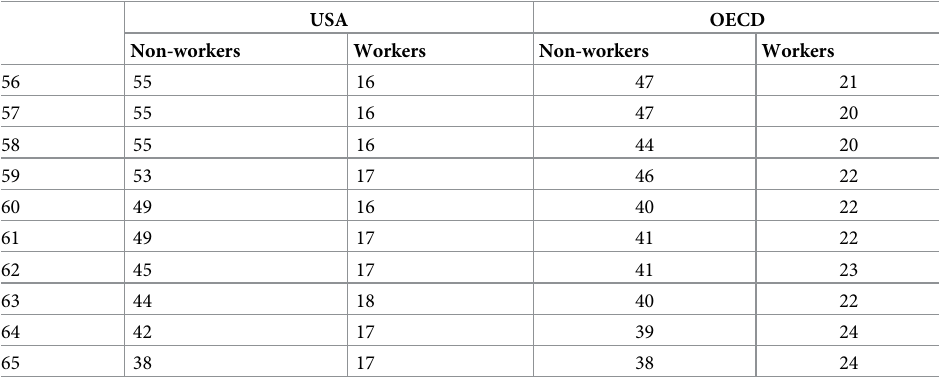
pain rates in the United States through age 60. When we change employment rates in the United States they resemble the age profile of pain elsewhere in the OECD. We are then left with the puzzle: why should pain be hump-shaped among the non- employed after they hit their early 50s in both the United States and the rest of the OECD? Some of the explanation may lie in early death rates of the non-employed which are linked to their high pain incidence. But most of it is likely due to the movement of workers into non- Table 3. Percent with health problems in the US and